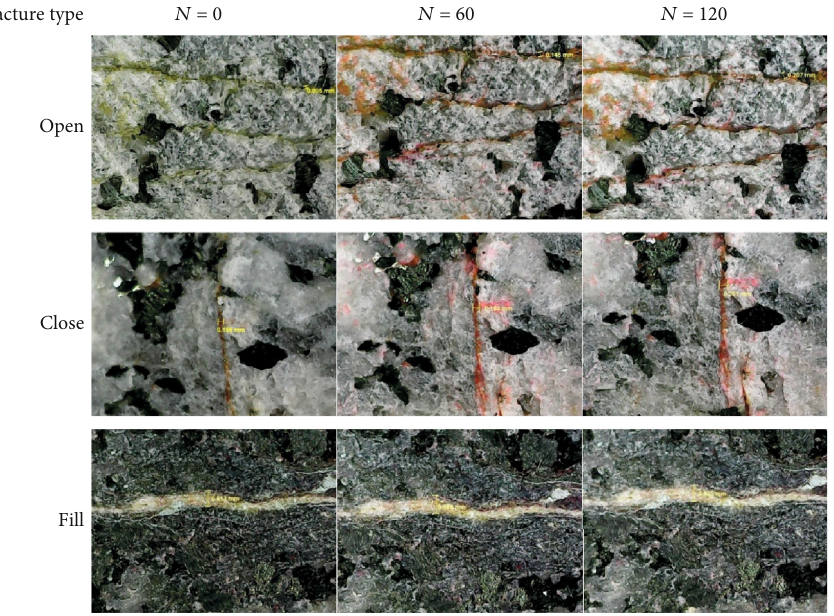
Figure 7: Fracture aperture changes with increasing F-T cycles. Three kinds of typical fracture of primary structural plane of open type, close type, and fi lled type were observed by the digital